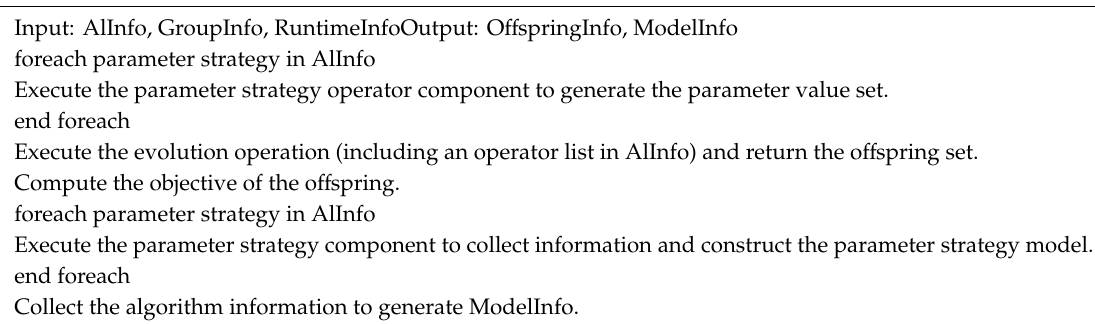
Algorithm 1. Single-step behavior of search agent.